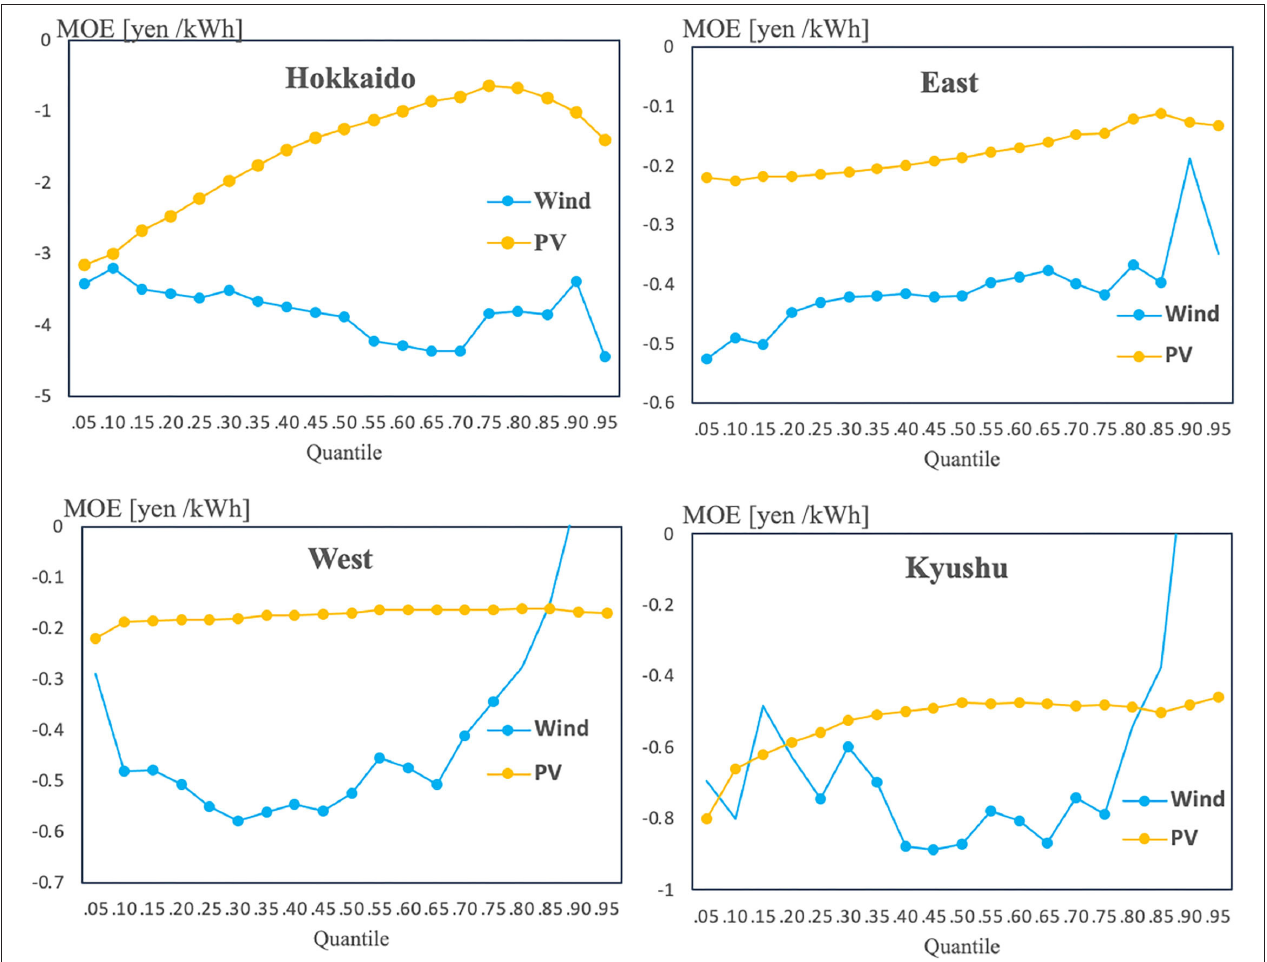
FIGURE 6 | The results of the quantile regression analyses of the price of each area. (Source: created by authors). The dots in the graph indicate significance at the 1% level.